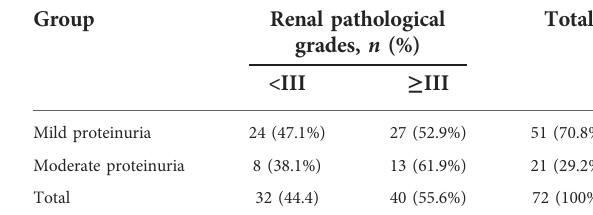
TABLE 5 Comparison of renal pathological grades ≥ grade III between the mild proteinuria and moderate proteinuria